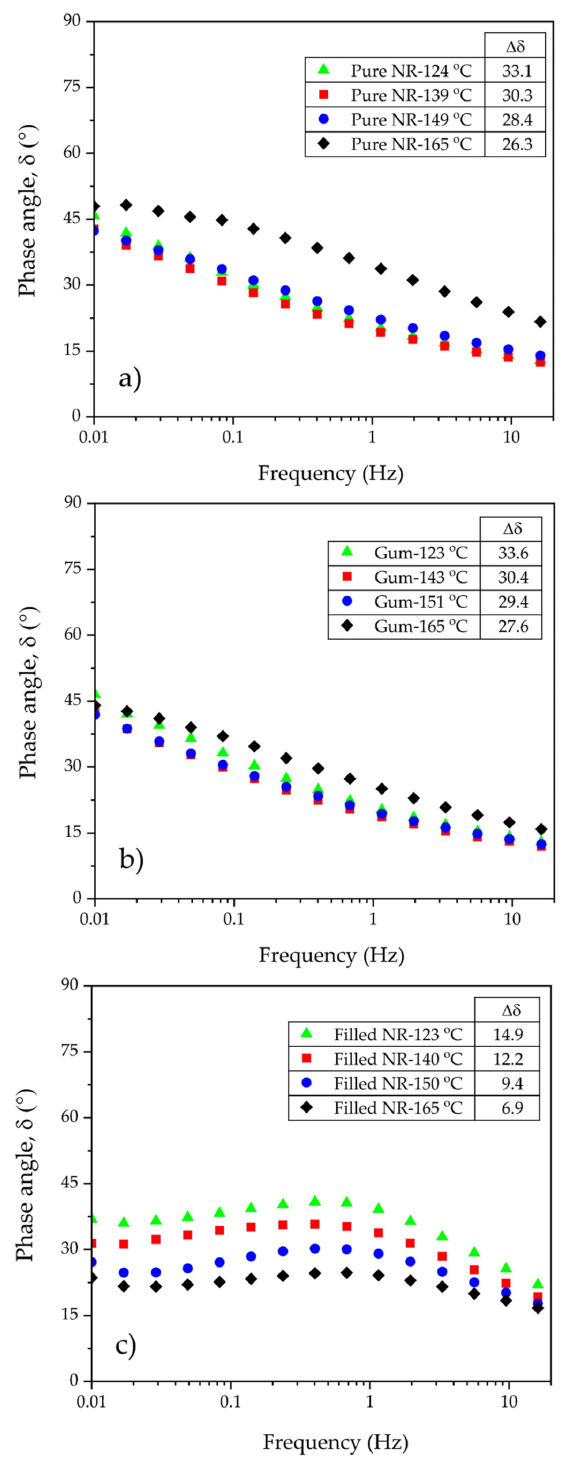
Figure 5. Delta or viscoelastic phase angle as a function of frequency for the pure ( a ), gum ( b ), and filled NR ( c ) compounds subjected to different dump